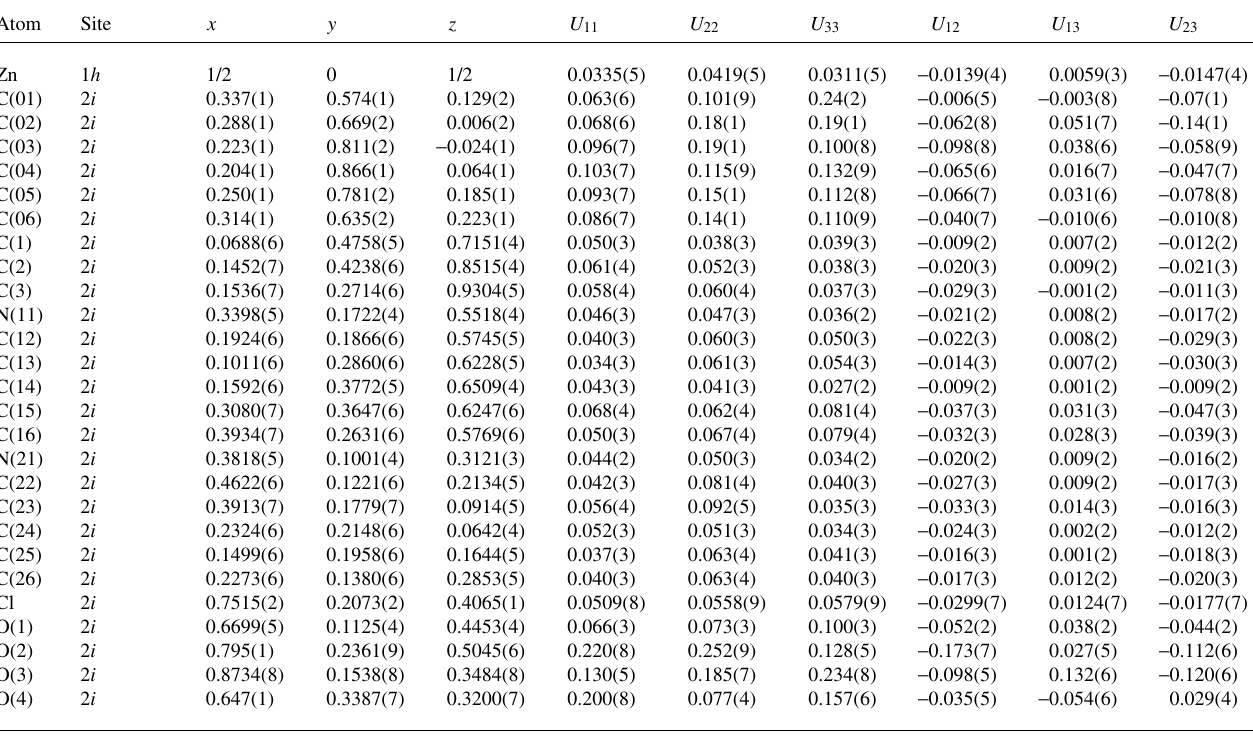
Table 6. Atomic coordinates and displacement parameters (in Å 2 ) .